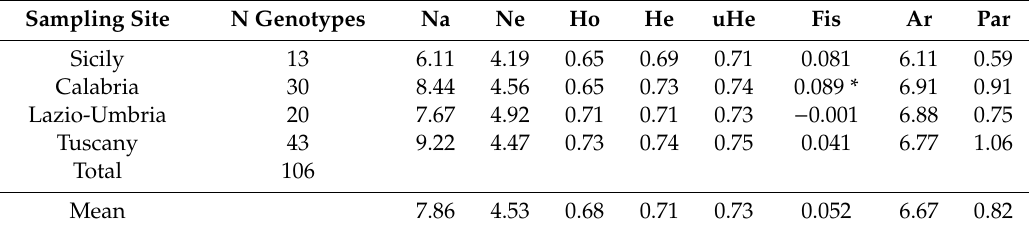
Table 3. Genetic diversity of large old trees grouped for collection sites: Sicily, Calabria, Lazio–Umbria, Tuscany.